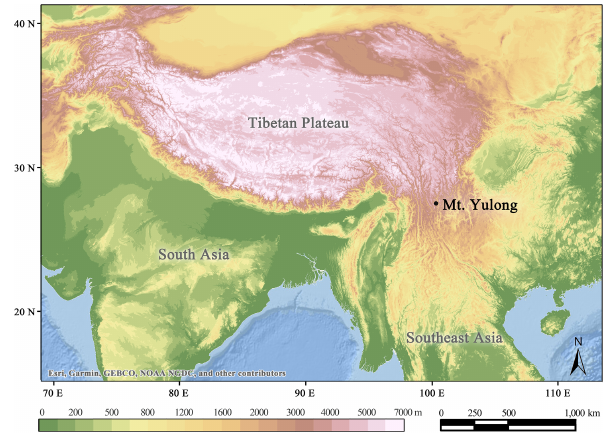
Figure 1. Location of measurement site at Mt. Yulong. Elevation data from the Shuttle Radar Topography Mission (SRTM) 90m dig- ital elevation model (DEM) Version 4; base map from the Environ- mental Systems Research Institute (ESRI) World Ocean Base; ma- nipulating by ArcMap Version 10.2, Redlands,